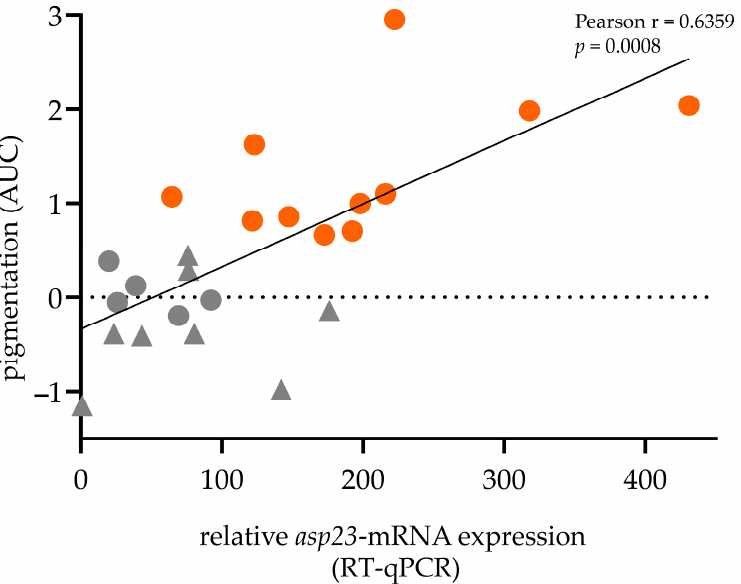
Figure 3. Asp23 -transcriptional expression positively correlates with staphylococcal pigment production. Pearson correlation coefficient (Pearson r), correlation p -value, and best-fit line (linear) shown. Orange: Fully pigmented isolates (n = 11), which are considered SigB-functional; Grey: Non- and intermediate-pigmented isolates (n = 13) including isolates presenting the SigB-deficient phenotype (n = 8;